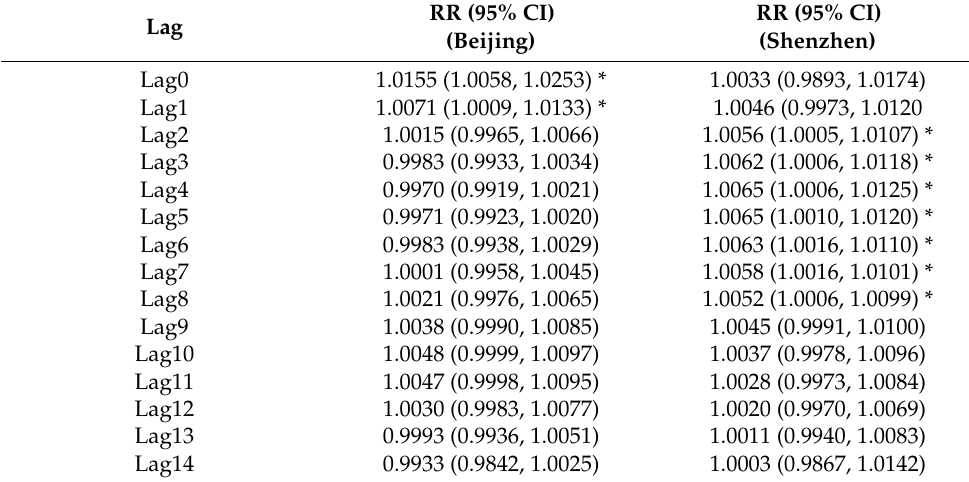
Table 2. Relative risk (RR) values for AECOPD in single-day lag mode in associations with 10 µ g/m 3 increase in PM 2.5 concentrations in 2013. (Value with * is significant at the 0.05 level).